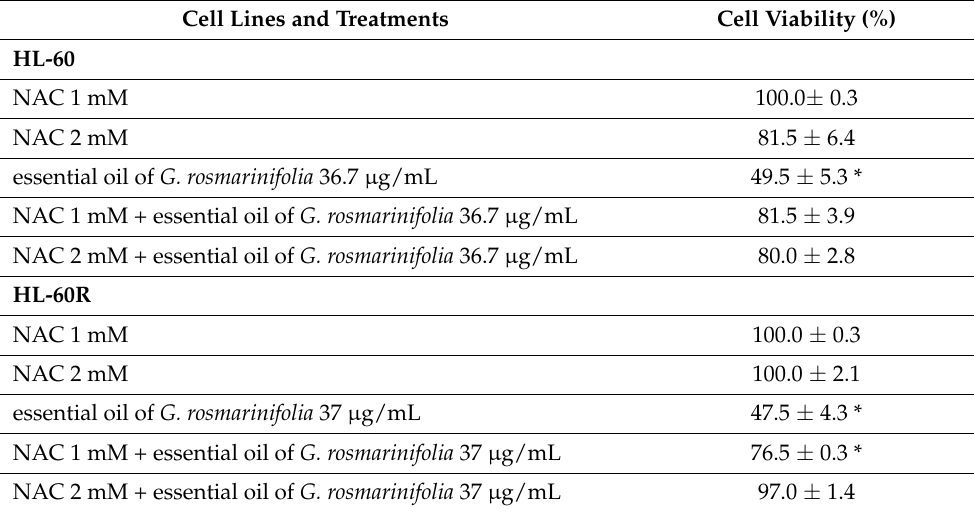
Table 2. Results of cell counting analysis in HL-60 and HL-60R cell lines following treatment with antioxidant N-acetyl-L-cysteine (NAC) at two concentrations, 1 mM and 2 mM, before exposure to EO at the corresponding IC 50